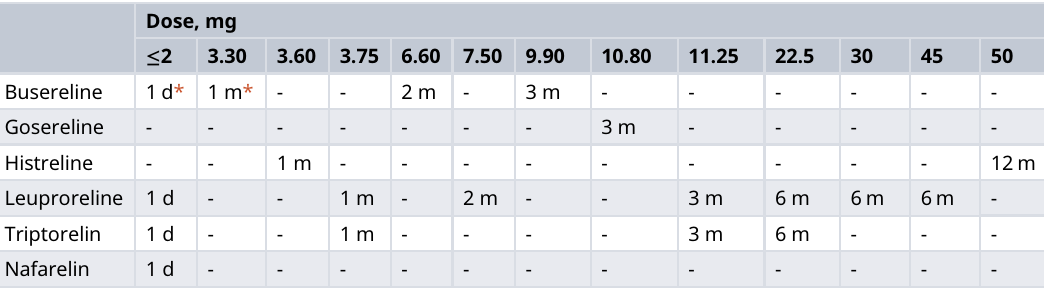
Table 1. LHRH analogue sustained-release formulations used, including dose and expected duration of